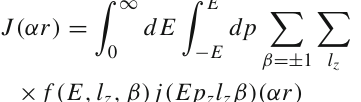
ally above the electroweak scales [30]. The electroweak sym- metry breaking scales are of the order of 100 GeV. If we substitute the value of η in the equations, we get the cur- rent in terms of GeV 3 . The numerically obtained values of J (α r ) are plotted in Fig. 1. The distance from the core is in terms of α r . Here α